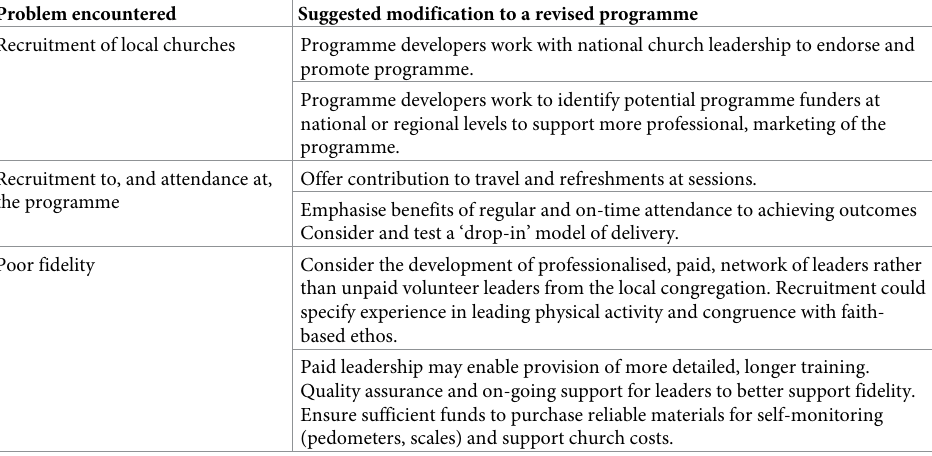
Table 11. Suggested modifications to Impilo neZenkolo prior to further